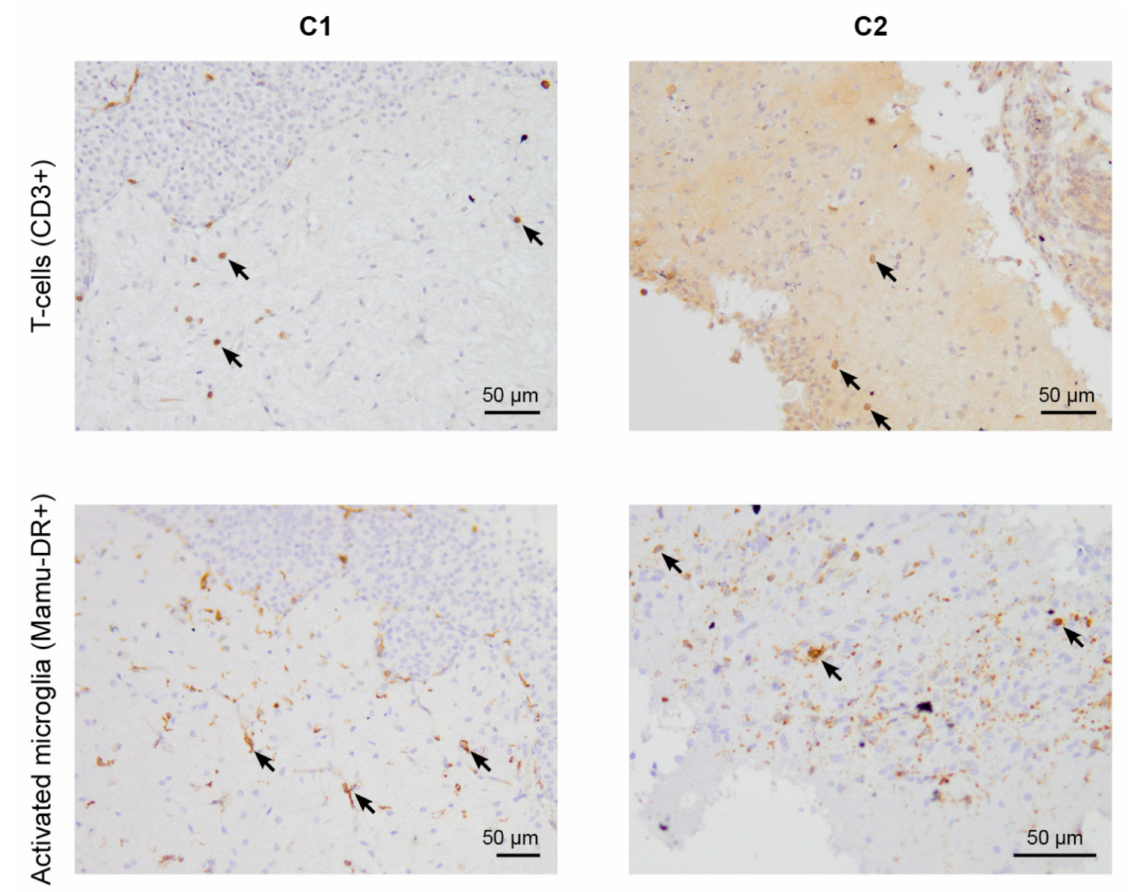
Figure 2. Immunohistochemistry for T-cells and activated microglia (some positive cells are indicated with arrows) of SARS-CoV-2-infected brain sections of cynomolgus macaques C1 and C2. The presence of T-cells (CD3+) (top level) and activated microglia cells (Mamu-DR+) (bottom level) in the pituitary gland of monkeys C1 ( left ) and C2 ( right ), observed five weeks after